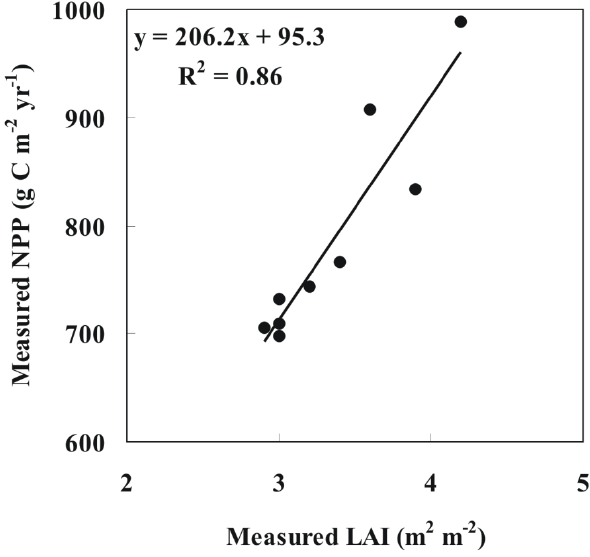
Fig. 3. Relationship between measured annual NPP and measured Figure 3. Relationship between measured annual NPP and measured LAI. NPP was 2 LAI. NPP was calculated based on tree ring increment and biomass calculated based on tree ring increment and biomass measured in the field, and LAI 3 measured in the field, and LAI was measured using TRAC in 2004. was measured using TRAC in 2004. 4